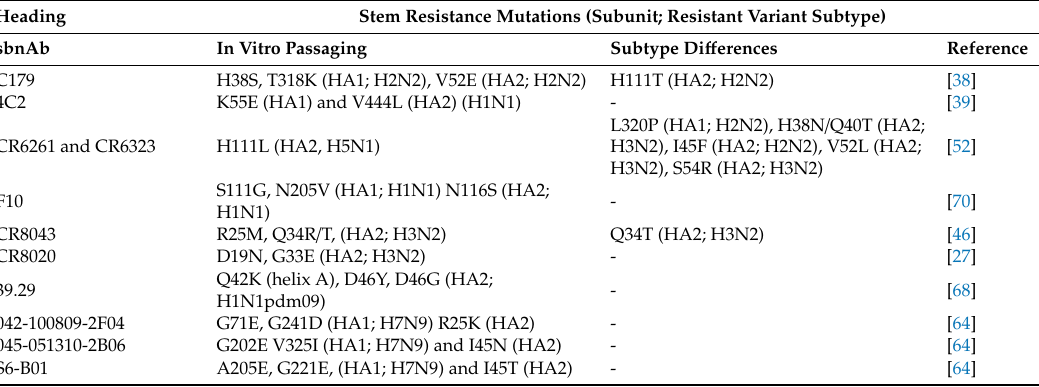
Table 2. List of the mutations and the subtype-specific di ff erences conferring sbnAb